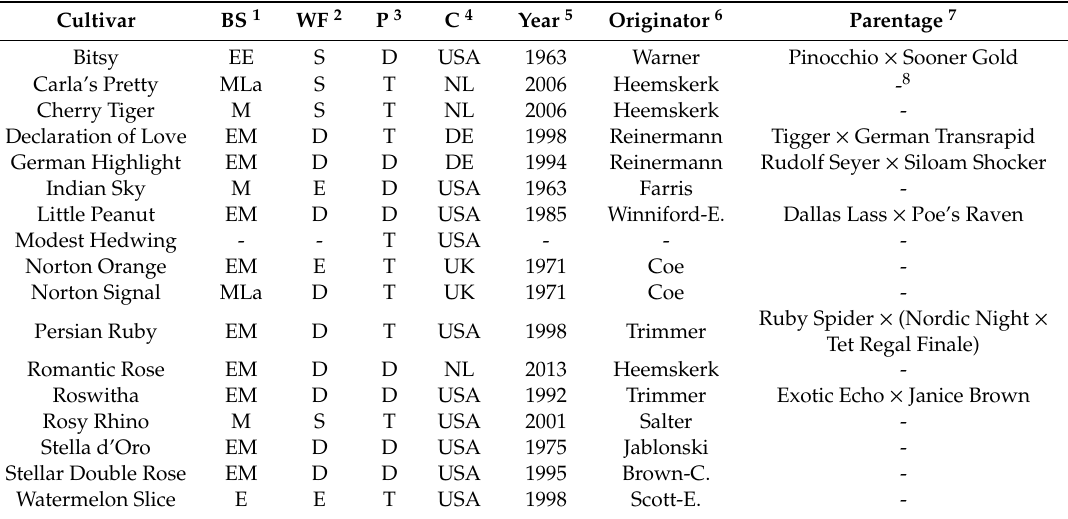
Table 7. Hemerocallis cultivars used in this study, bloom season, winter foliage, ploidy, year of registration and